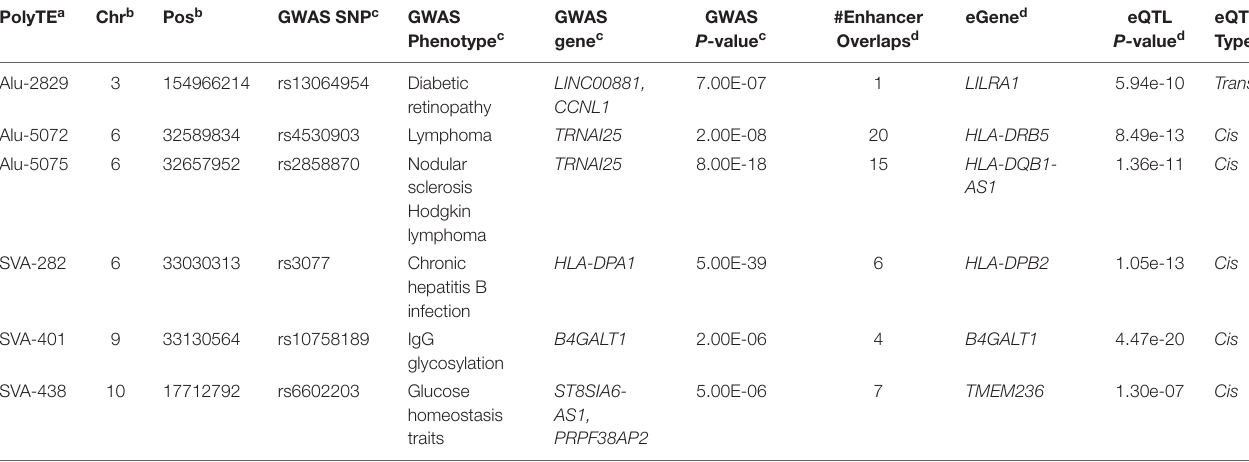
TABLE 1 | PolyTE disease associations.